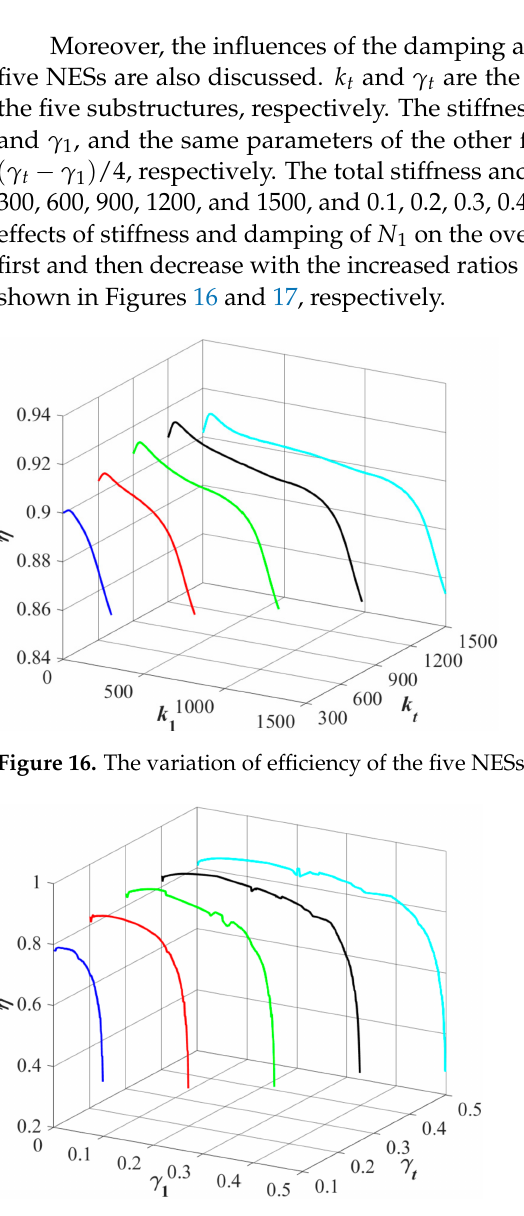
Figure 17. The variation of efficiency of the five NESs with the damping of N 1